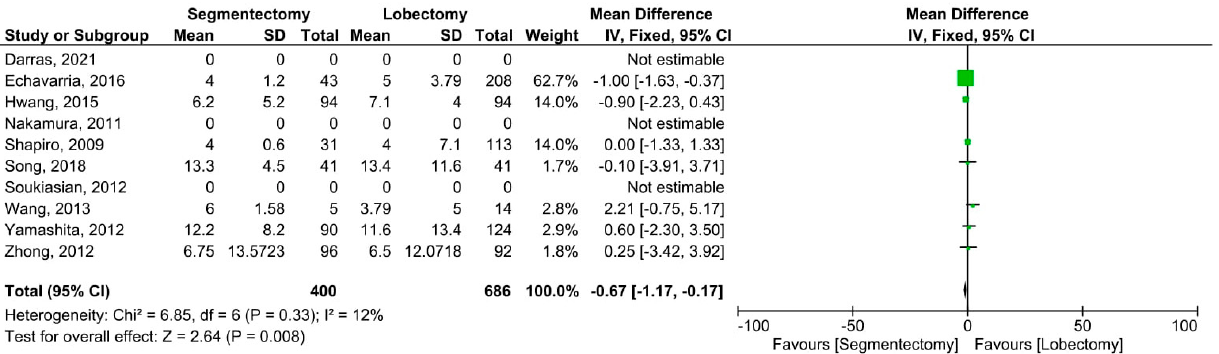
Figure 5. Forest plot for the minimally invasive segmentectomy and lobectomy postoperative hospital stay. CI = confidence interval; dF = degree of freedom; IV = inverse variance; SD = standard deviation [8,12–20].